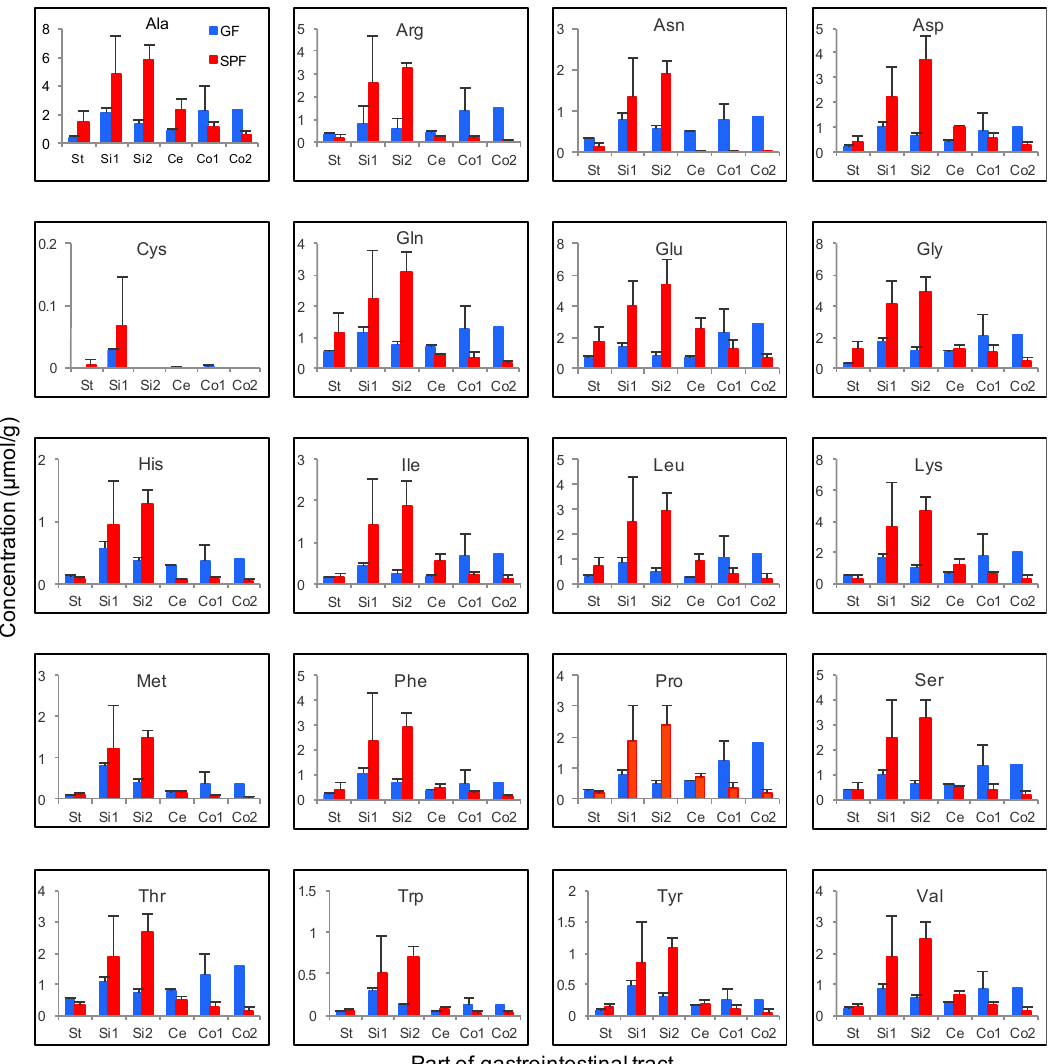
Stomach, Si1: Upper small intestine, Si2: Lower small intestine, Ce: Cecum, Co1: Upper colon, Co2: Lower colon. Unit: μ mol/g.